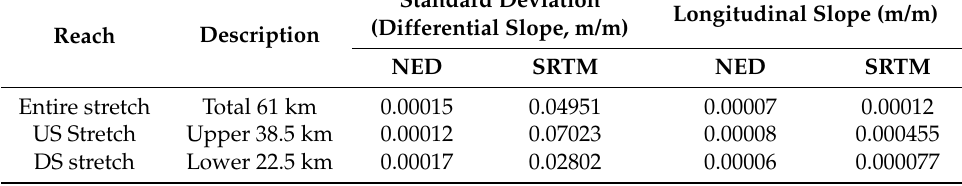
Table 1. Summary of differential slopes (slope between two consecutive cross-sections) and longitudinal slopes calculated from the National Elevation Dataset (NED) and the Shuttle Radar Topography Mission